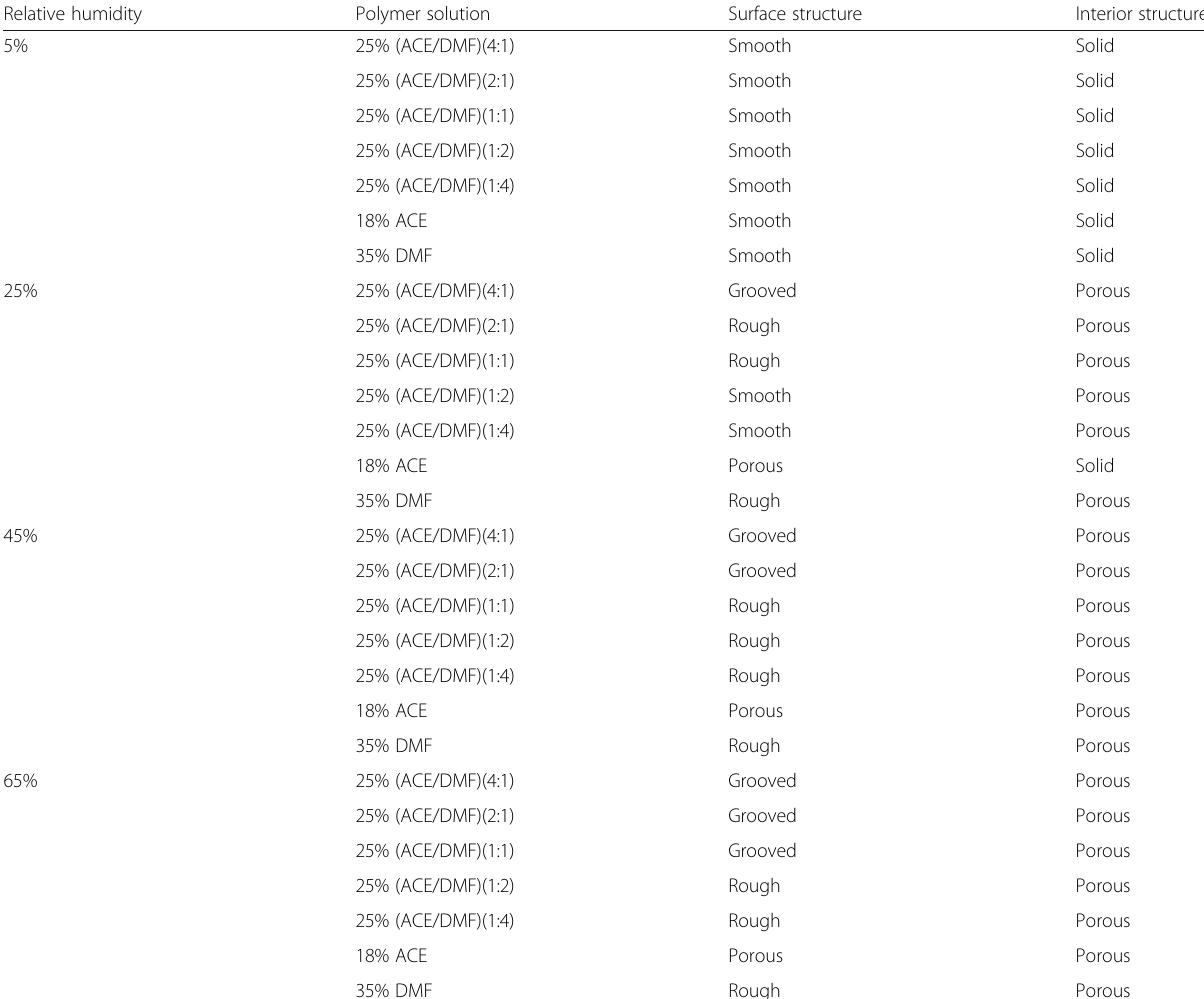
Table 1 Summary of the morphologies of the PVDF fibers and their interiors obtained in this work at different levels of relative humidity and polymer solutions Relative humidity Polymer